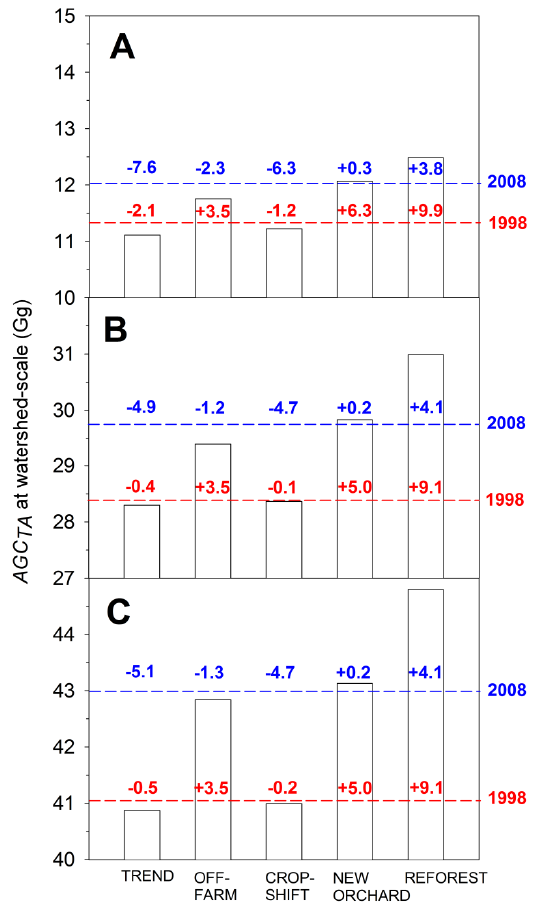
Figure 8. Time-averaged above-ground carbon ( AGC TA ) stocks (in Gg) computed with the coupled Dyna-CLUE carbon-accounting procedure per scenario in 2009–2029 at the watershed-scale, with ( A ) referring to employed minimum ( AGC TA -MIN ), ( B ) average ( AGC TA -AVG ), and ( C ) maximum ( AGC TA -MAX ) value input data; dashed lines refer to AGC TA stocks in 1998 (blue) and 2008 (red). Values denote the percentage change in AGC TA in 2029 compared to1998 and 2008.